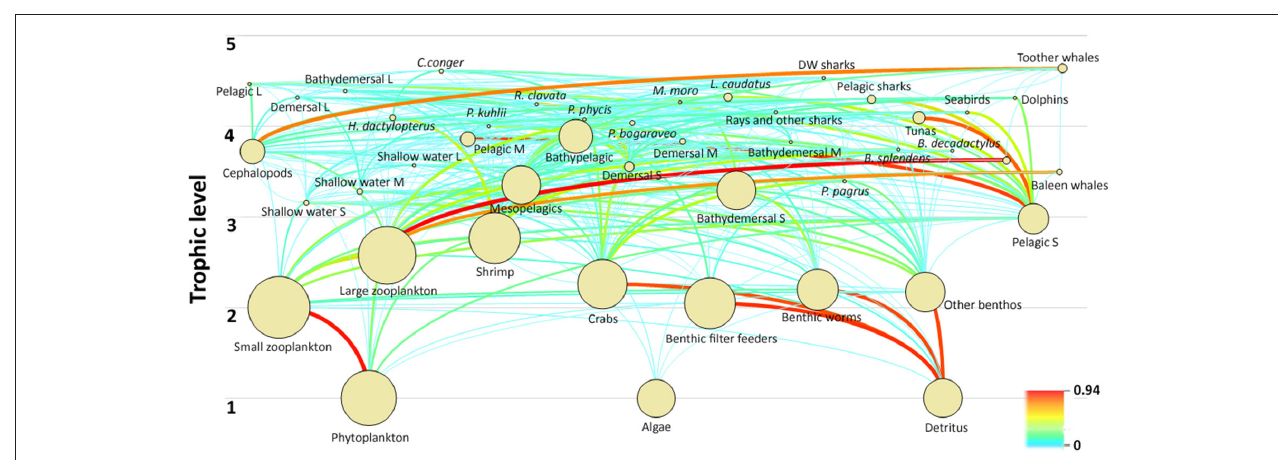
FIGURE 5 | Diagram of the food web and trophic flows of the Azores ecosystem model for the reference year 1997. The circles are dimensional representations proportional to the logarithm of group biomasses and the lines indicate the trophic links among functional groups.